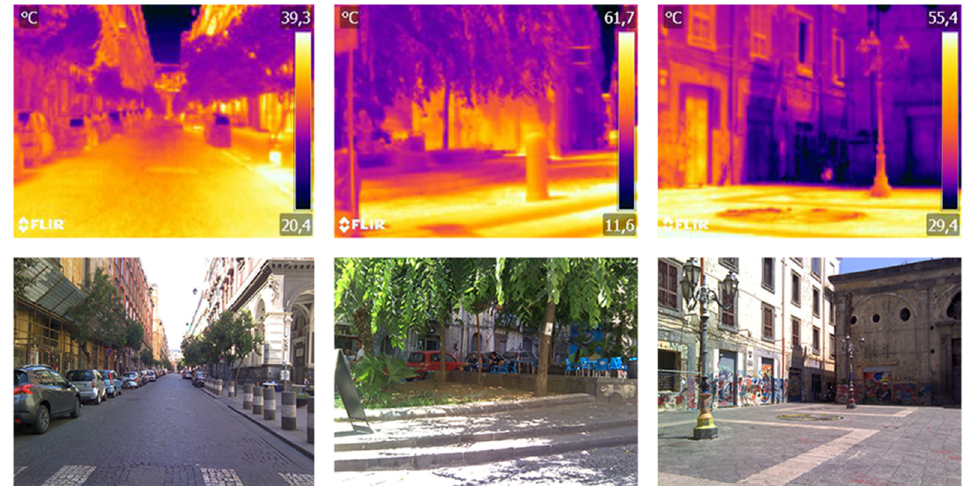
Figure A3. Thermographic surveys of the 5 August 2014 of Duomo Street (P9), Largo San Giovanni Maggiore (P5), Banchi Nuovi Square (P4).